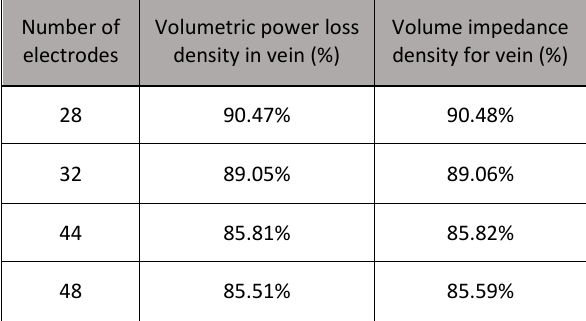
Table 1: Simulations results including the percentage of the volumetric power loss density and volume integration of volume impedance density for vein and with the electrode dimensions of r t = 1 mm and r g = 0.5 mm where all the surface electrodes were excited simultaneously as terminals.